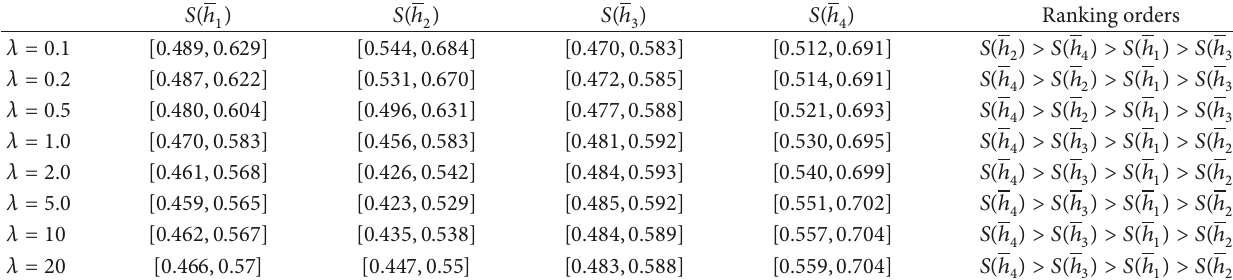
Table 11: Ranking results based on the GIVHFHA operator.